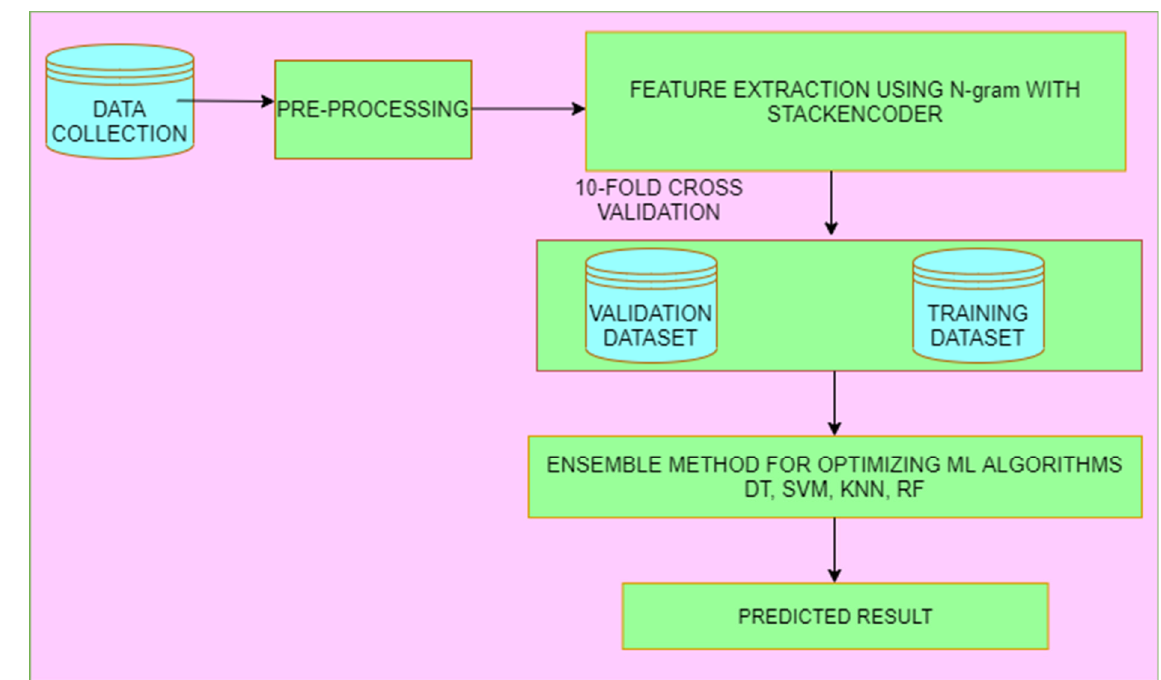
Figure 1. Proposed architecture for N-Gram Stacked